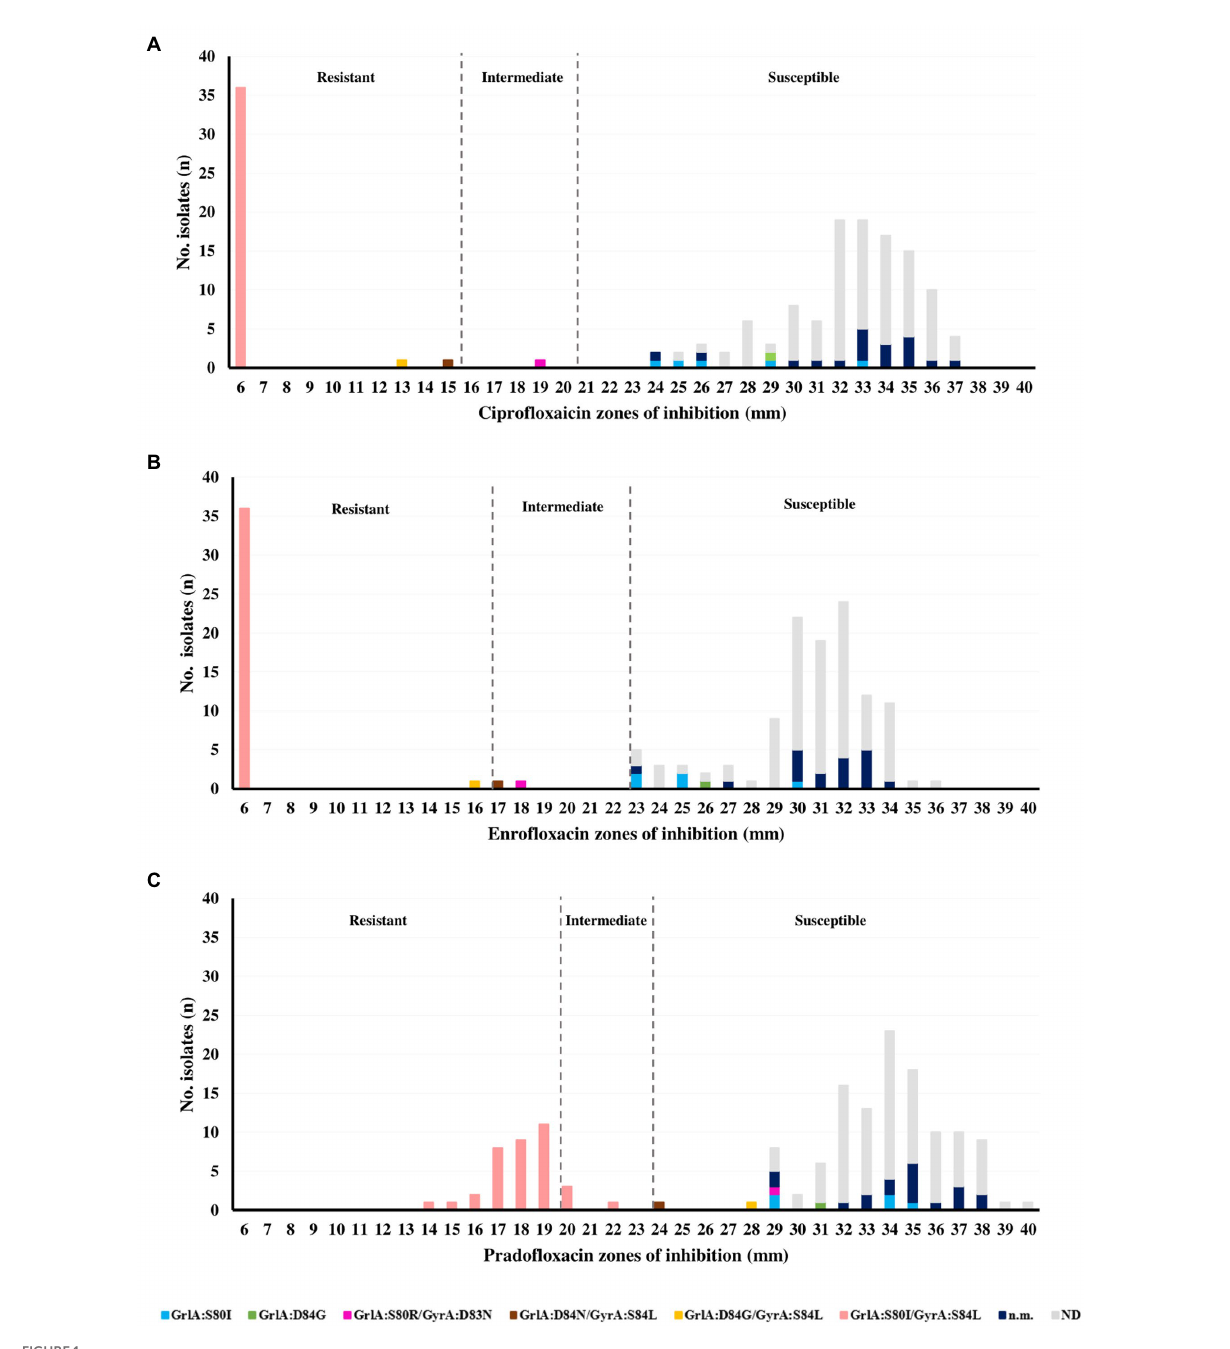
FIGURE 1 Relation between the zones of inhibition and QRDR mutations obtained for (A) ciprofloxacin, (B) enrofloxacin, and (C) pradofloxacin in the Staphylococcus pseudintermedius collection ( n =